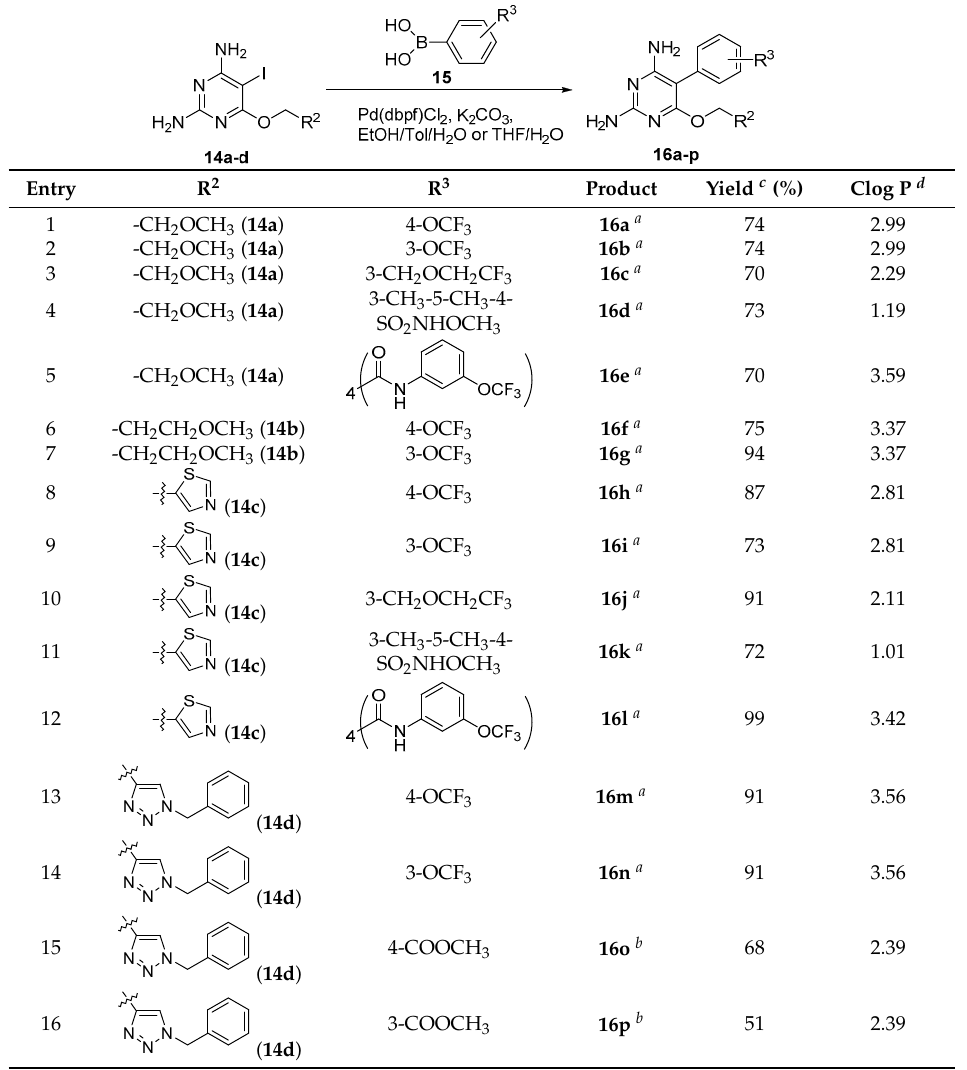
Table 1. Synthesis of 2,4-diamino-5-aryl-6-substituted pyrimidine derivatives 16a-p via Suzuki reactions.